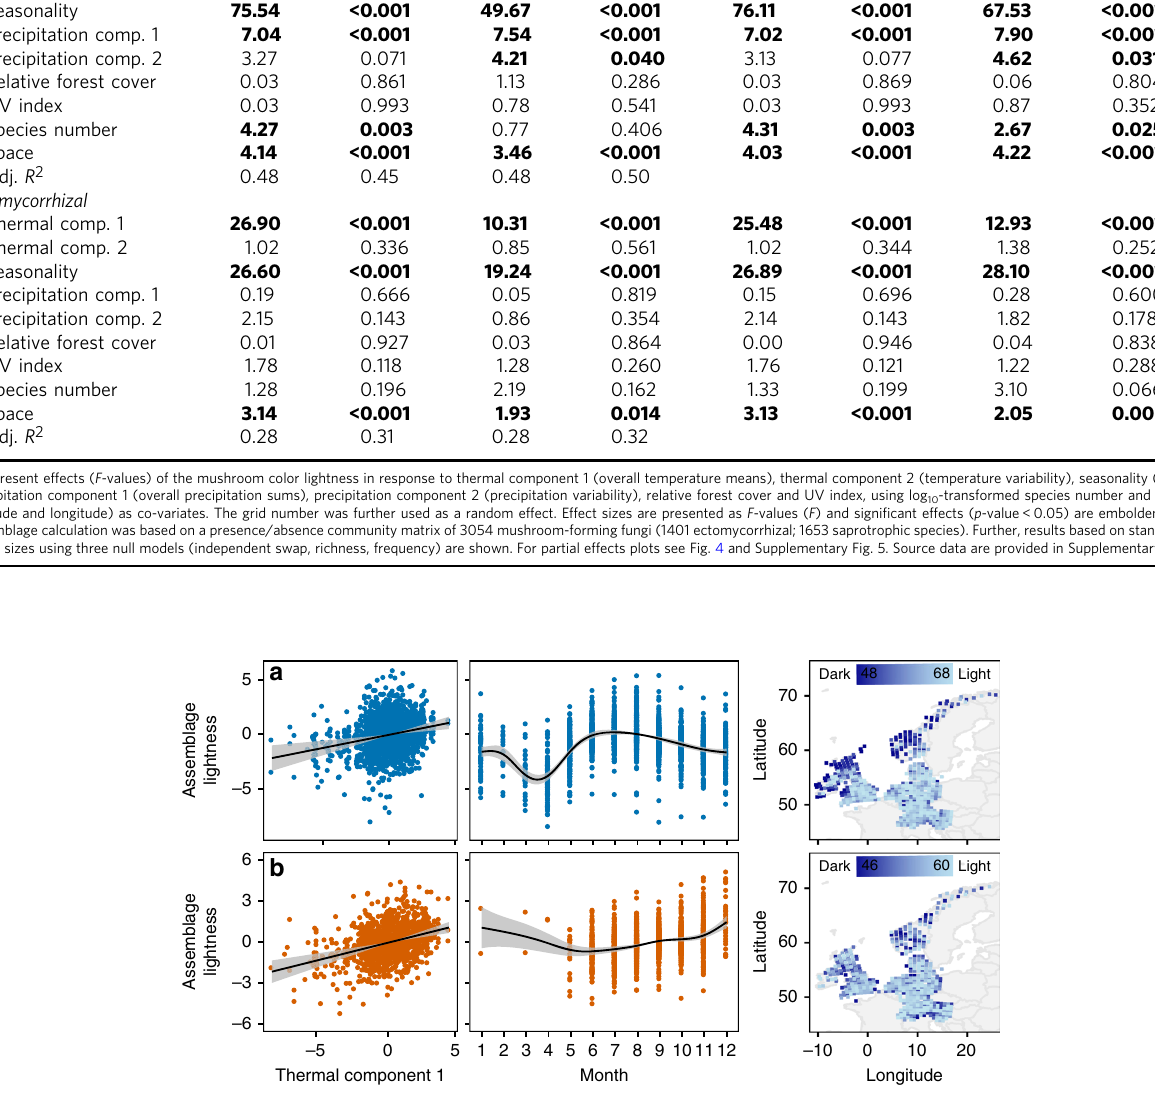
Fig. 4 Partial effects of temperature and seasonality on mushroom color lightness. Included here are four orders (Agaricales, Russulales, Boletales, and Cantharellales) of the systematic class Agaricomycetes (Basidiomycota) spanning 3054 species. Partial effects of thermal component 1 (mean temperature) and month on the mushroom color lightness of a saprotrophs (blue) and b ectomycorrhizal fungi (orange). Maps show mushroom color lightness across Europe. Maps were created using the R package ggplot2 with the function borders. Slopes are estimates from generalized additive models (GAMs) with standard deviations (Table 1 for GAM statistics). Source data are provided in Supplementary Data (precipitation component 1) on mushroom color lightness of saprotrophs ( F -value = 7.04) but no signi fi cant effects on ECM fungi (Supplementary Fig. 5; Table 1). The model of saprotroph mushroom color lightness showed a higher explained variance ( R ² = 0.48) than the ECM model ( R ² = 0.28, Table 1). Further, these results remained consistent under three null models accounting for various potential sampling biases, such as uneven species richness, species frequency or both (Supplementary Fig. 6;